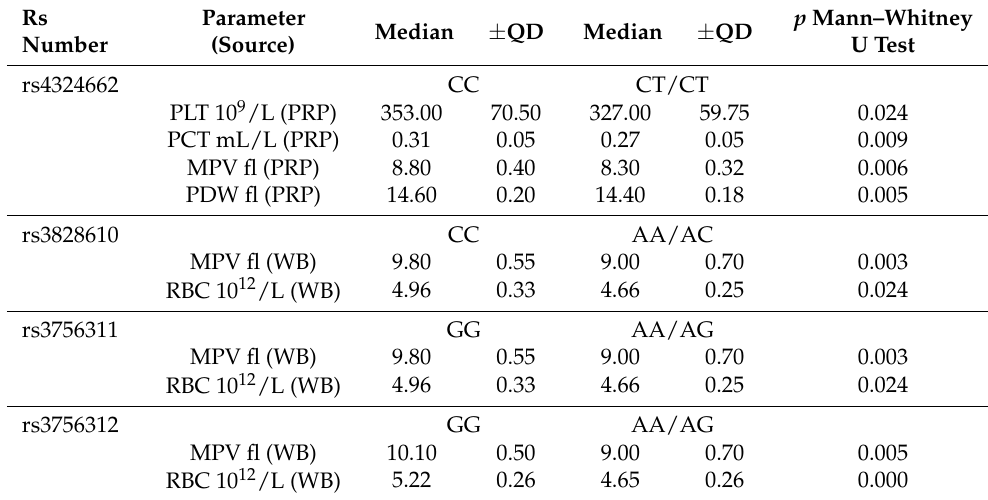
Table 3. Whole blood (WB) and platelet-rich plasma (PRP) parameter values with respect to the PDGFRB gene polymorphisms variants (dominant/recessive